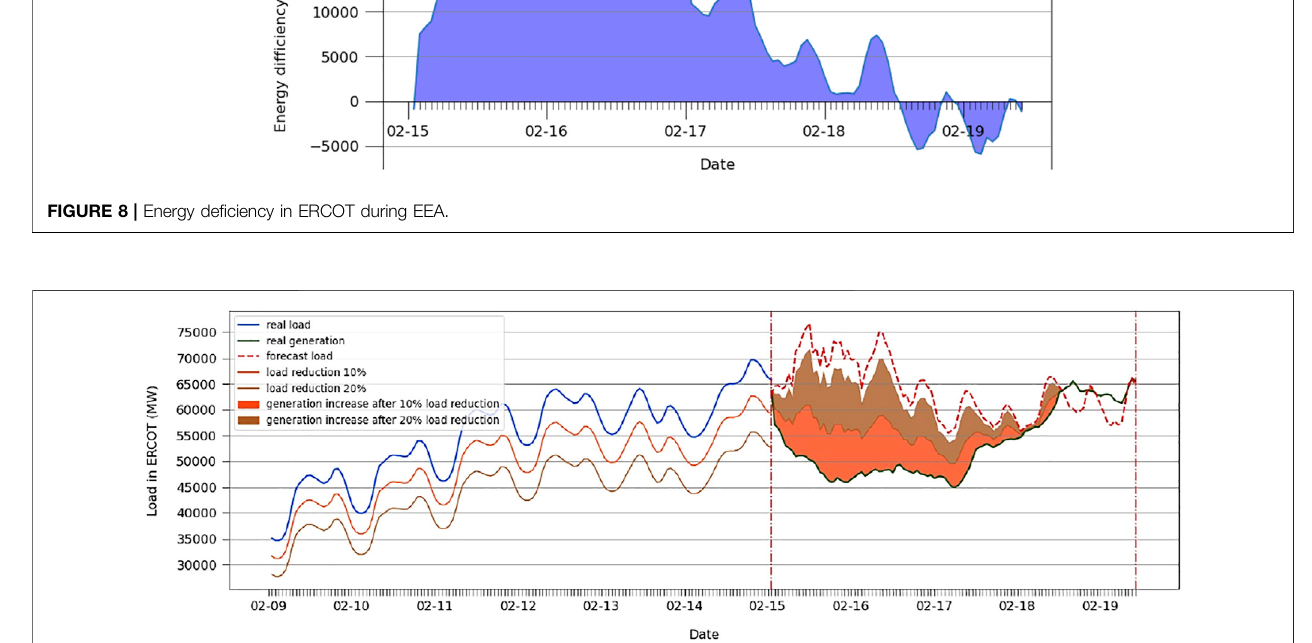
FIGURE 9 | Effect of pre-event load conservation on mitigating energy de fi